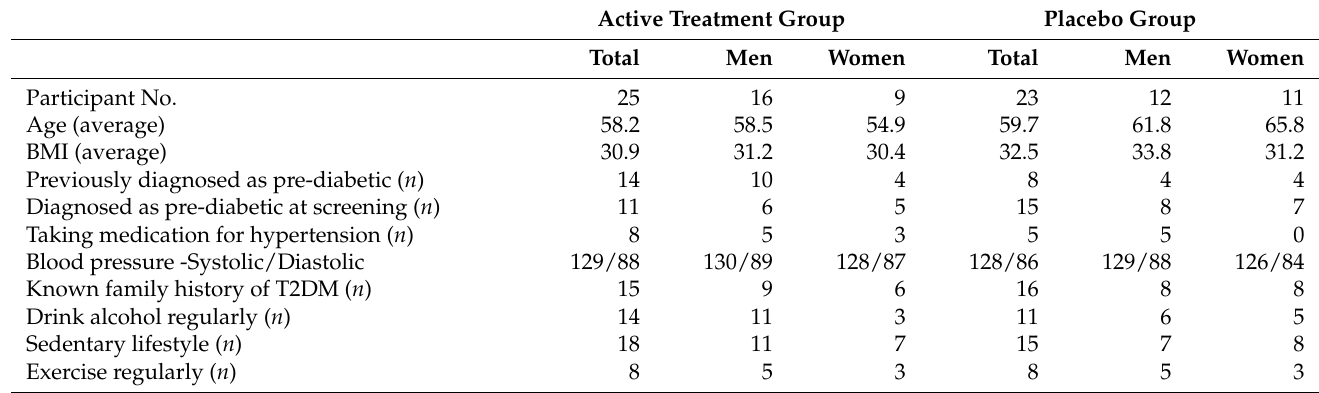
Table 1. Demographics of participants in the Active treatment group and Placebo group at baseline.